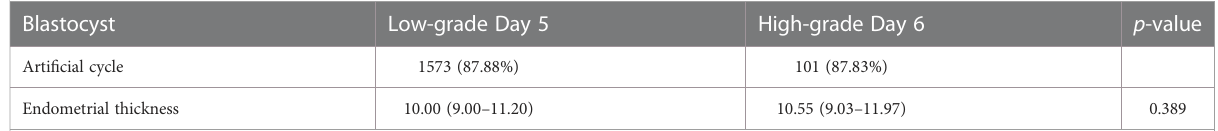
(Table 3) to calculate the ORs between low-grade D5 and high- grade D6 blastocysts adjusted for female age ( ≤ 35 and >35 years), parity (0, 1, and ≥ 2), ET times (1st, 2nd, and ≥ 3rd), and blastocyst status(expanded,hatching,andhatched).TheLBRachievedinhigh- gradeD6blastocysttransferwassigni fi cantlyhigherthanthatinlow-